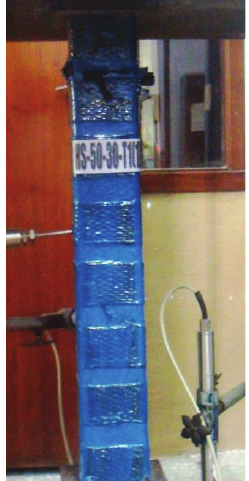
Figure 8: Failure mode of column HS-50-30-T1 (1) .